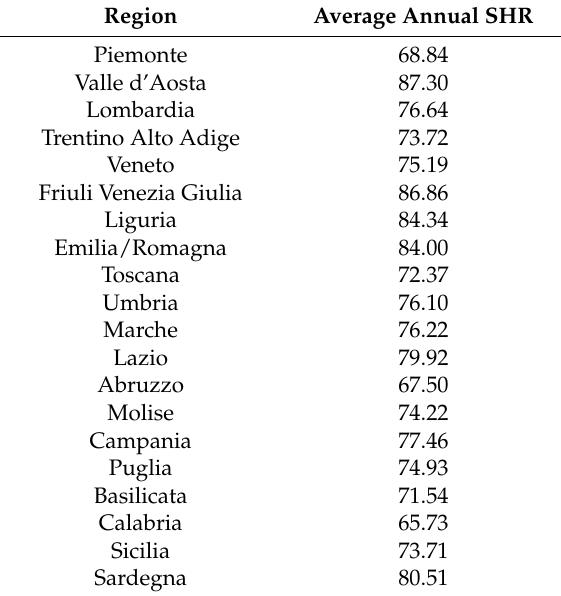
Table 1. Overall cancer standardized hospitalization rate per region in population aged 0–100 years old (Average Annual